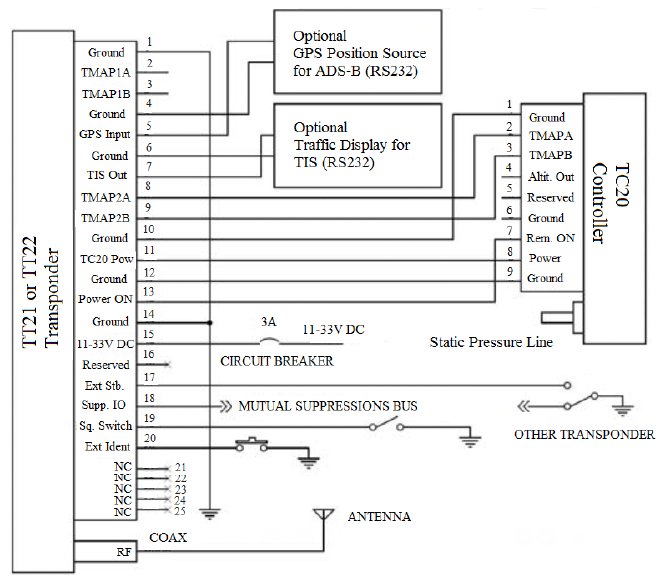
Figure 14. TT21 transponder connections.